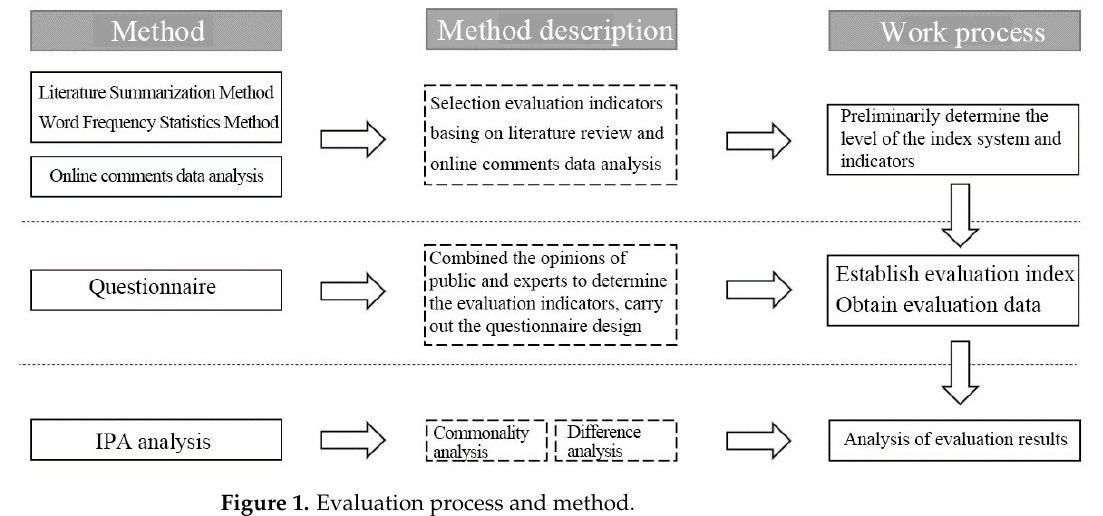
Figure 1. Evaluation process and method.